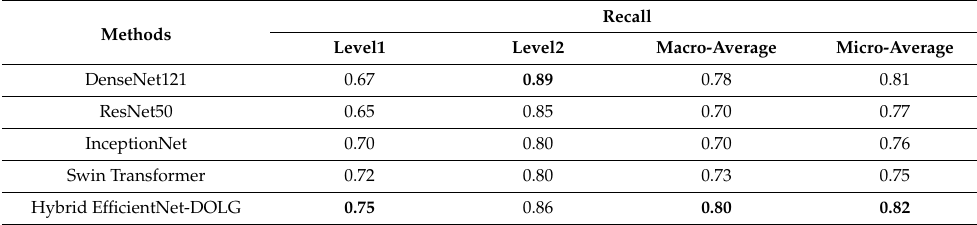
Table 8. Comparing results between the five deep learning models on the COVID-19 severity assessment task with respect to recall metric.